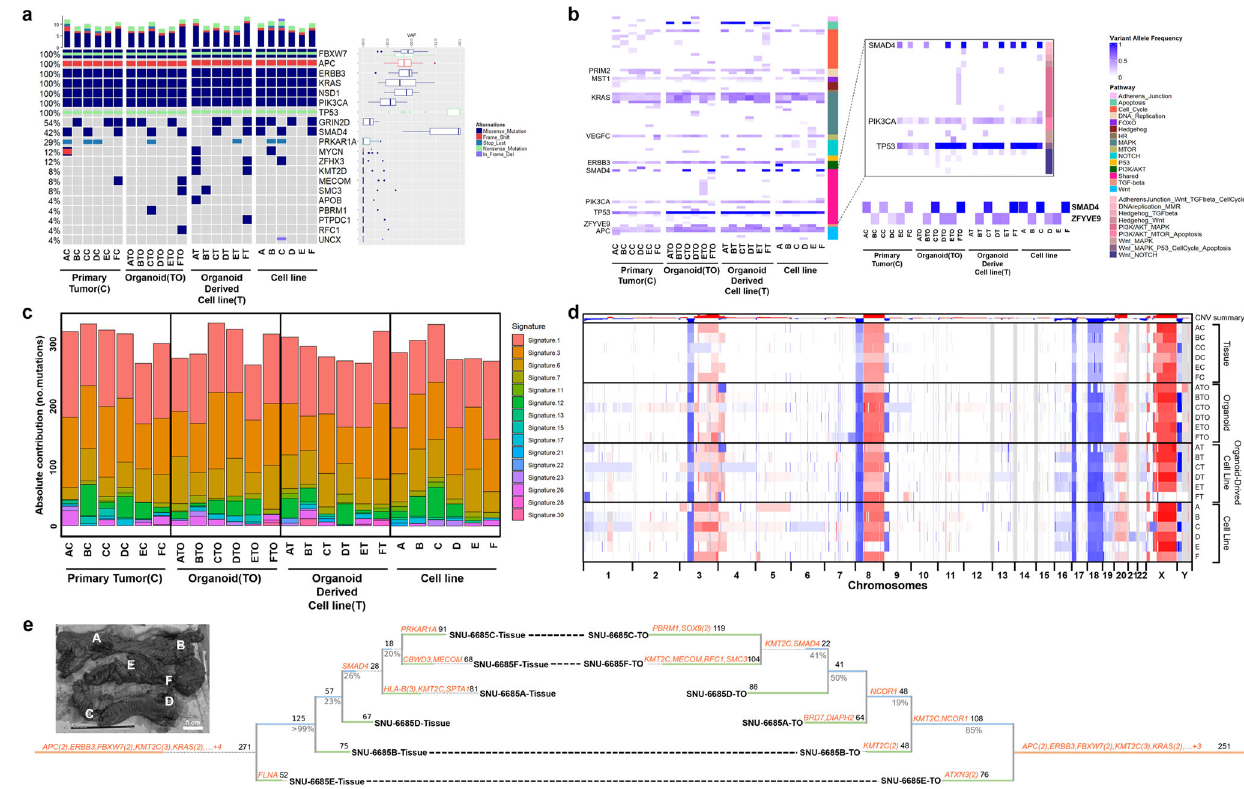
Fig. 2 Sub-regional analysis of genomic characteristics of PDOs and PDCs revealed evolutionary trajectories of SIC. See also Supplementary Figs. 2 and 3 . a Genomic pro fi les of original tumors and their derivatives of the patient, SNU-6685. Multiple somatic mutations including point mutations in putative tumor driver genes were identi fi ed. Variant allele frequencies (VAFs) of somatic mutations are indicated with a box plot on the right side of the heatmap. Each speci fi c type of alteration is marked with representative colors. b Heterogeneous distributions of VAFs in somatic mutations involved in multiple signaling pathways. Derivatives regardless of the different culture methods preserved VAFs of corresponding tumors in the majority of cell signaling pathways ( n = 11). Within a single patient, genes regulating TGF- β signaling pathways such as SMAD4 and ZFYVE9 exhibited subregional clone-speci fi c VAFs. c Total mutational load and mutational signatures of derivatives and paired primary tumors. The different colors represent different signatures ( n = 30). d Genome-wide copy number variations (CNVs) of synchronous tumor tissues and their derivatives (red, gains; blue, losses; white, diploid). CNV patterns were analogous regardless of different culture methods as well as the multi-focal tumor sites. e Phylogenetic trees illustrating the evolutionary trajectory of SIC tissues and corresponding PDOs. Based on multiregional WES pro fi les, Treeomics classi fi ed somatic mutations as the trunk (orange), shared (blue), and individual (green). Dotted lines indicate the genetic hierarchical position of each site was mostly analogous between tissues and PDOs. Numbers on top of each branch indicate the number of acquired variants. Genes that are listed in the CGC are shown in orange. Numbers on the bottom of each branch indicate estimated support values. The actual photograph of the tumor shows the marked sites from which each subclonal derivative was obtained (A – F). Scale bars = 5